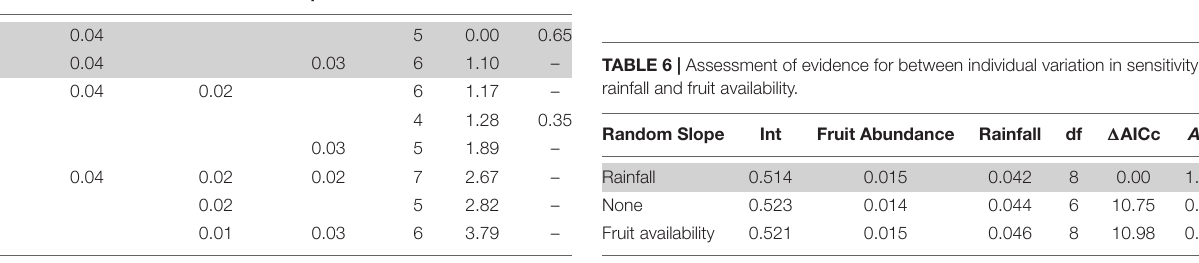
TABLE 5 | Model output for the factors influencing elephant movement at the follow-level. Int Fruit Abundance